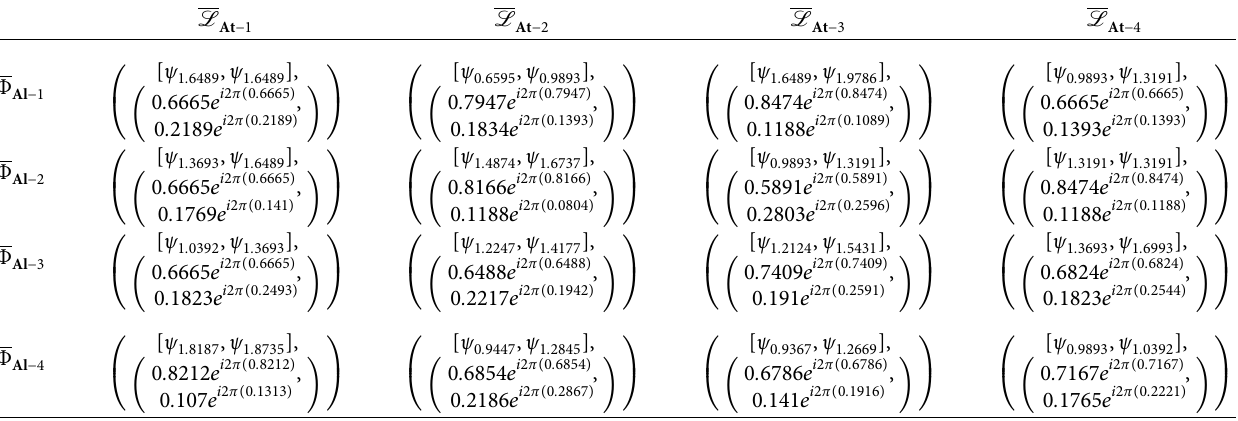
Table 4: Aggregated decision matrix of the experts by CIULWAHM operator.